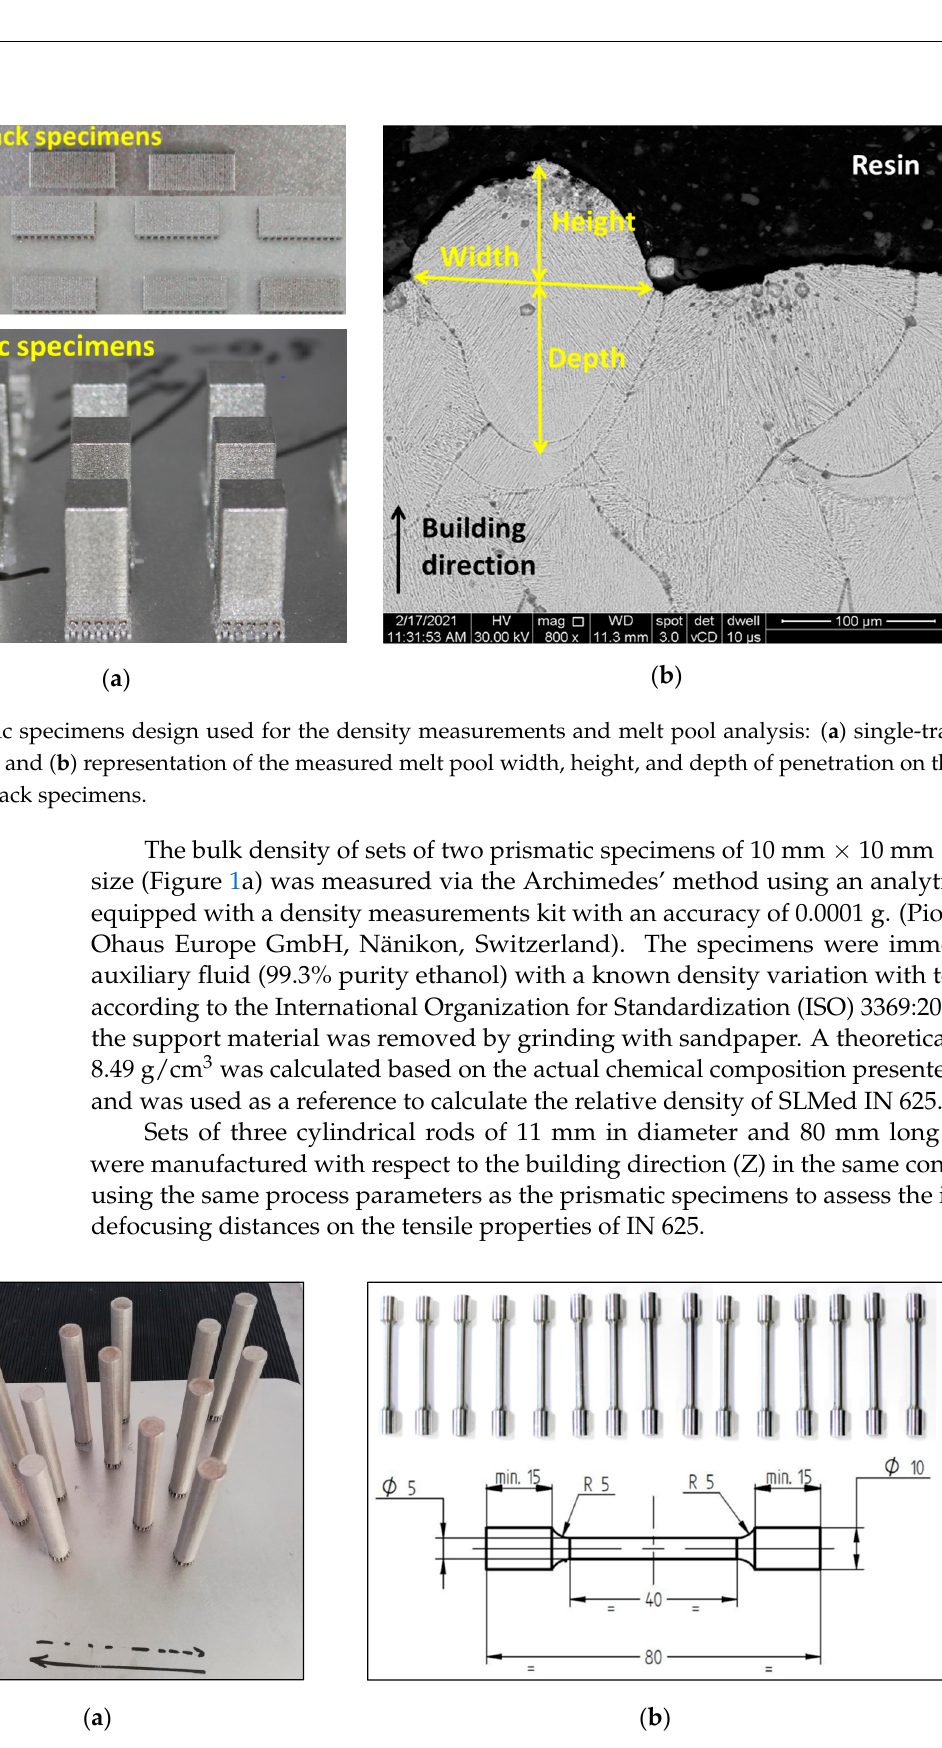
Figure 2. Tensile specimens: ( a ) cylindrical rods manufactured and ( b ) tensile specimen dimensions after machining (units in millimeters).